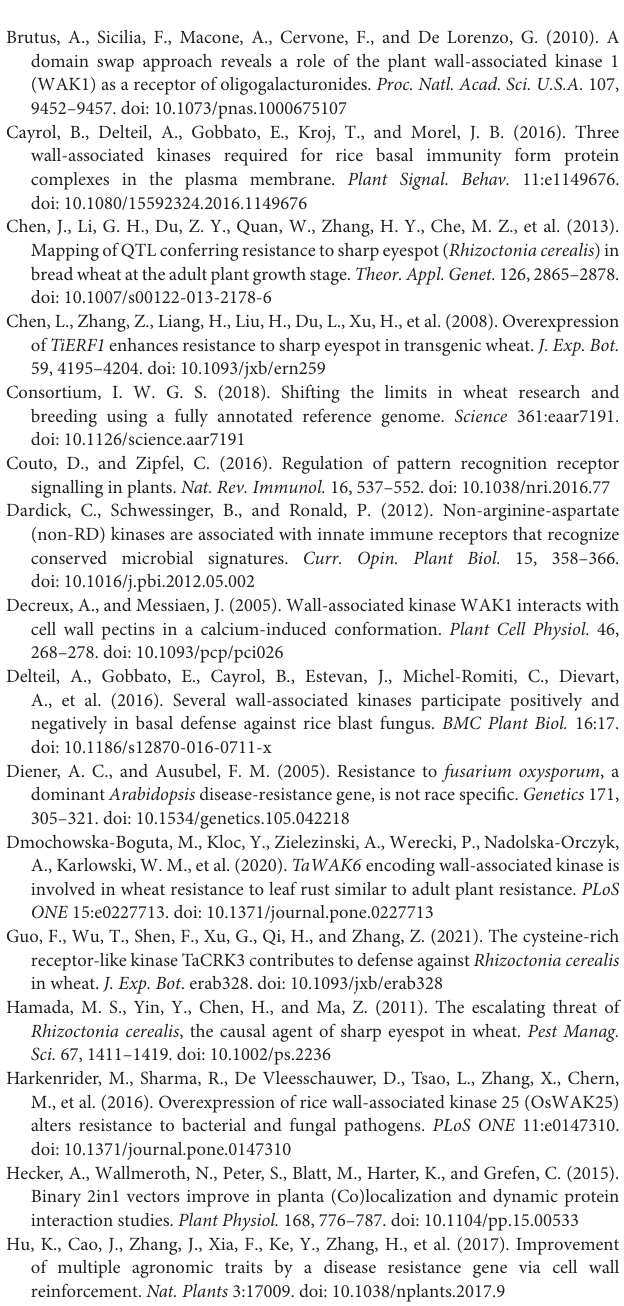
Supplementary Figure 6 | Comparison of Fusarium crown rot or sharp eyespot disease index (DI) between BSMV: GFP or BSMV: TaWAK-6D wheat plants. (A) Sharp eyespot DI of BSMV: GFP or BSMV: TaWAK-6D at 35 dpi with R. cerealis in two independent batches. ( t -test: ∗∗ P < 0.01). Bars indicate SEs of the mean. (B) Fusarium crown rot DI of BSMV: GFP or BSMV: TaWAK-6D at 30 dpi with F. pseudograminearum in two independent batches. ( t -test: ∗∗ P < 0.01). Bars indicate SEs of the mean. Supplementary Table 1 | Primers and their sequences used in this